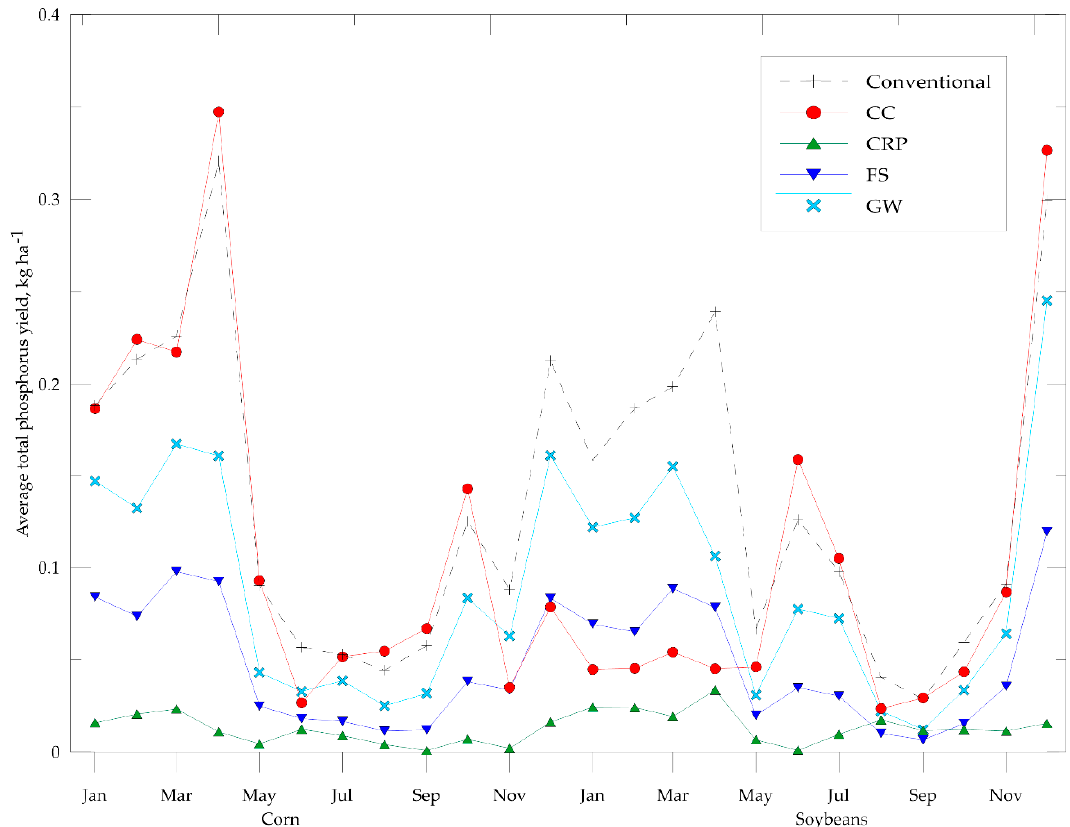
Figure 9. Average simulated monthly total phosphorus yields for the conventional rotation and selected best management practices (BMPs) for corn and soybean years. (CC = cover crops; CRP = conservation cover; CR = crop rotation; FS = filter strip; GW = grassed waterway.).